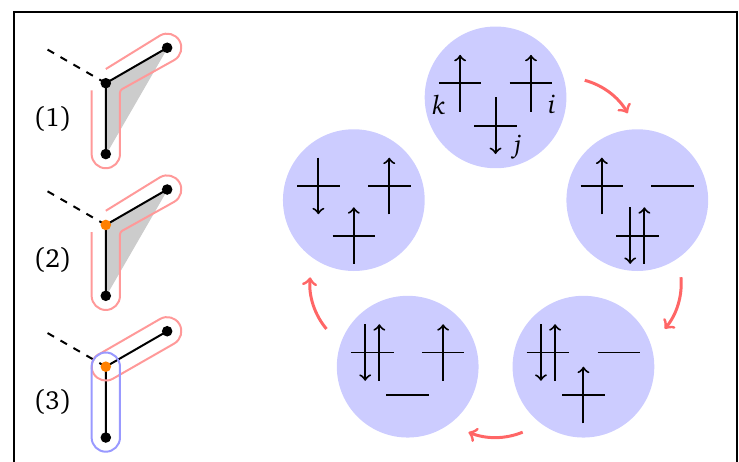
Figure 4: Light-induced scalar spin chirality. Illustration of the three classes of fourth-order hopping processes possible on the honeycomb lattice: ( 1 ) a process where the second intermediate state contains a single holon-doublon pair at non-zero Floquet index. ( 2 ) A process where the system returns to half-filling in the second intermediate step (at the orange site) at non-zero Floquet index. ( 3 ) A process where the system returns to half-filling and zero Floquet index in the second intermediate step (at the site indicated in orange). The right panel gives an example of a process in class ( 1 ) that breaks time-reversal symmetry and induces a scalar spin